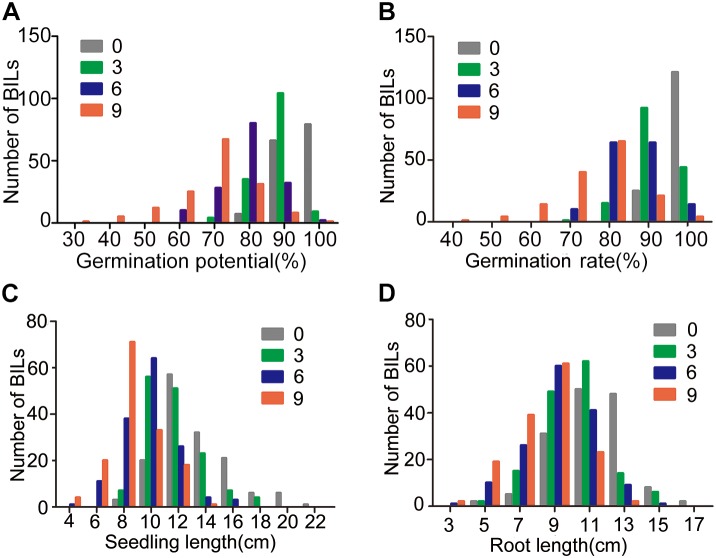
Phenotyping of seed vigor traits of 152 BILs under artificial aging treatments. (A–D) represent distribution graph for GP, GR, SL, and RL, respectively.